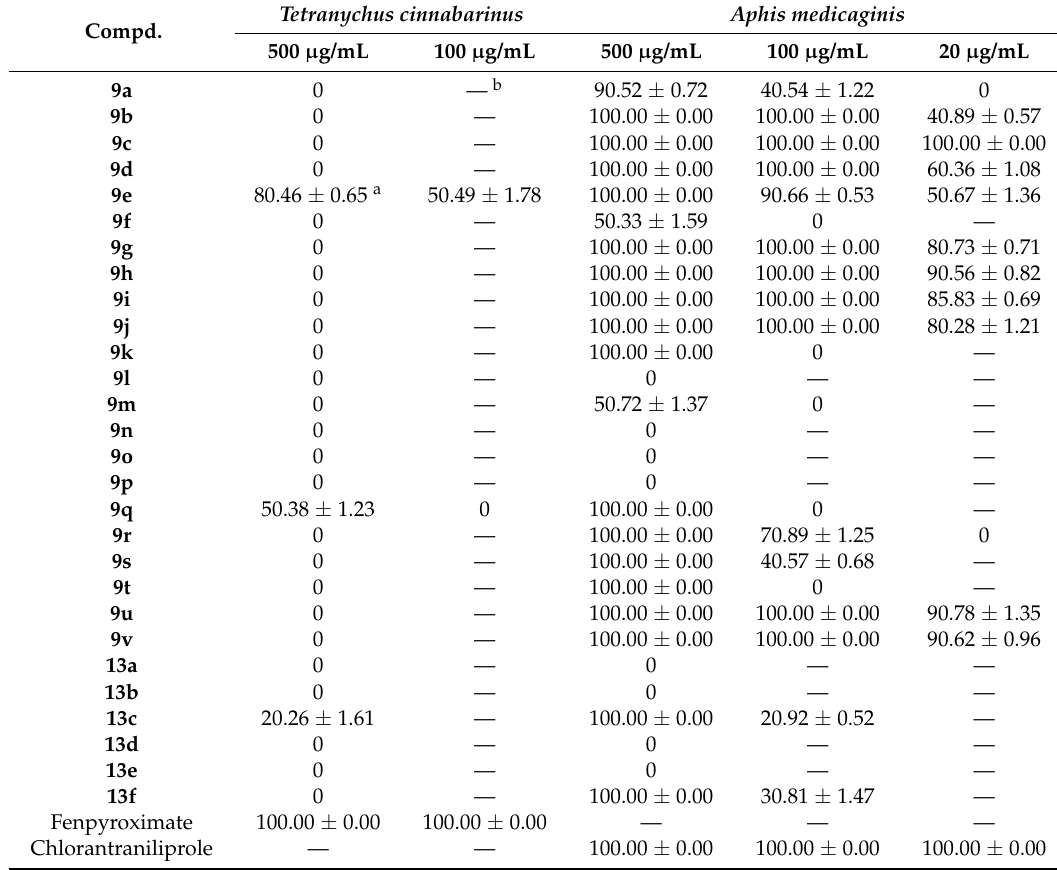
Table 1. Acaricidal and insecticidal activities of target compounds 9a – 9v and 13a – 13f (mortality, %). Compd.